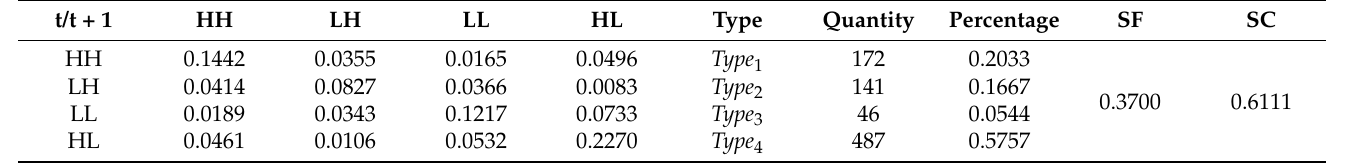
Table 4. Spatial-temporal transition matrix for Moran scatter plot of